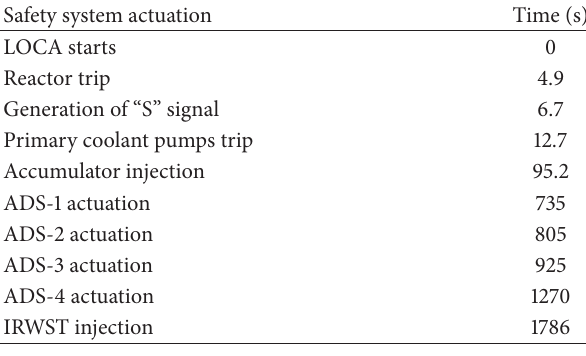
Table 3: Accident sequence during small break LOCA.